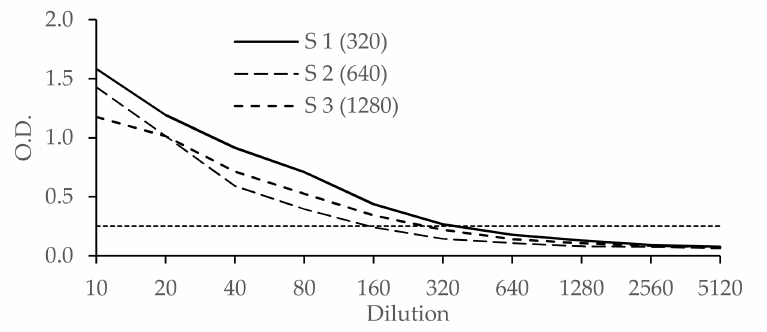
Figure 4. OD values of three BTV-4 ELISA-positive twofold serially diluted sera. In brackets the dilution up to which the serum was BTV-4 SNT-positive. The horizontal line represents the ELISA cut-off (OD = 0.25).